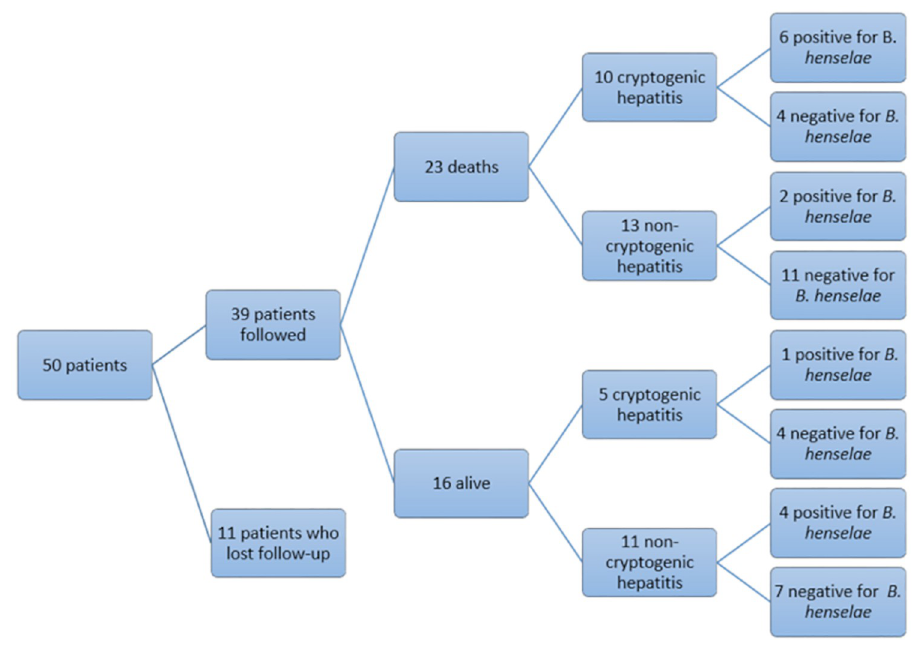
Fig 1. Evolution of the study of patients two years after the inclusion of the 50 th patient (non-cryptogenic: Alcoholic, drug-induced, and autoimmune).